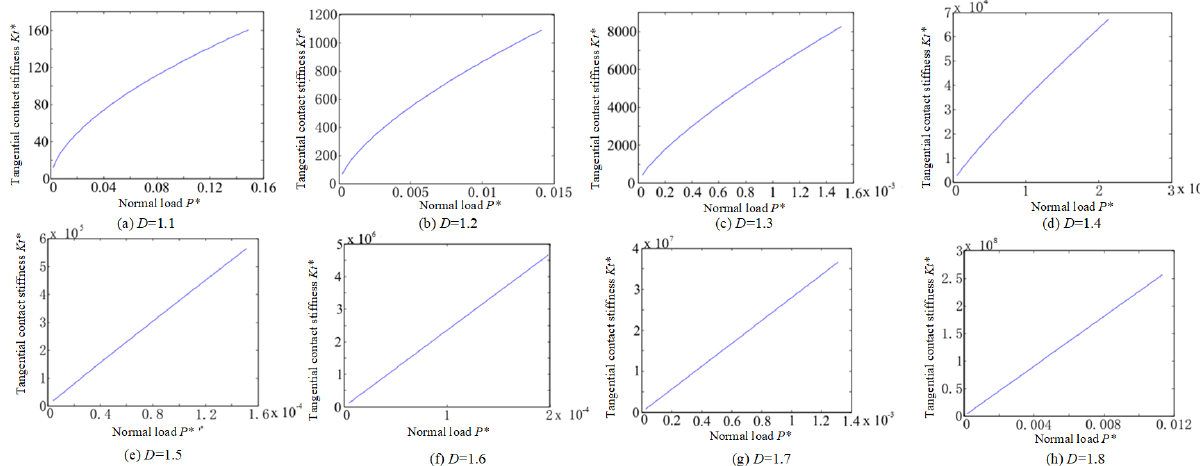
Figure 9. Effect of normal load P ∗ on tangential stiffness K ∗ t ( k = 1 . 0, φ = 1 . 0, v = 0 . 3, h = 0 . 02, G ∗ = 1 . 0 × 10 − 11 ).